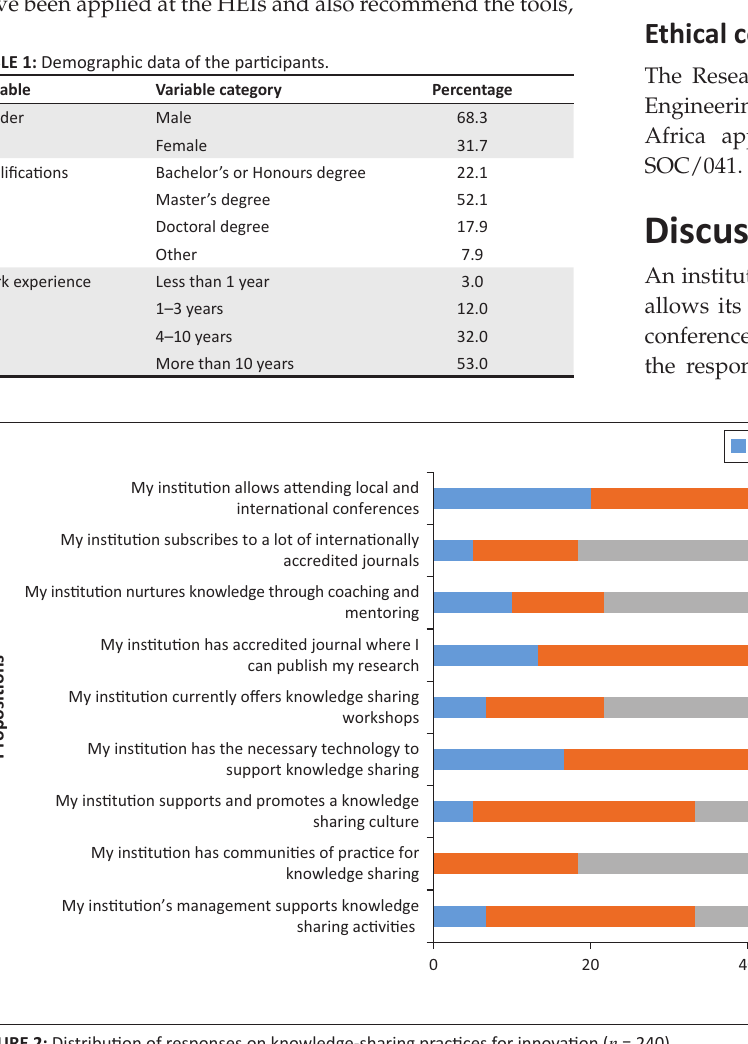
FIGURE 2: Distribution of responses on knowledge-sharing practices for innovation ( n = 240).